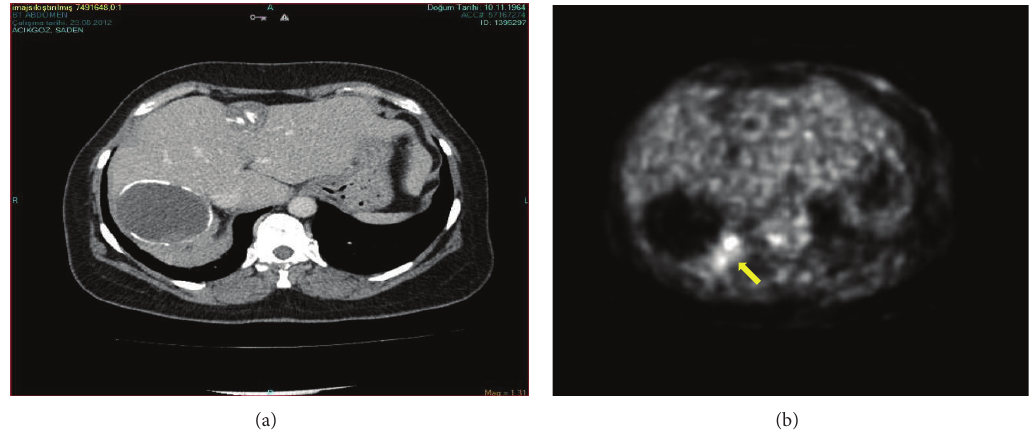
Figure 1: The radiological findings of the patient. (a) Abdominal computed tomography showing a 65×55 mm stage 5 hydatic cyst in the right hepatic lobe and a 30 × 28 mm in the left hepatic lobe, (b) FDG18 positron emission tomography of the patient on which the mass revealed a high activity of FDG. Yellow arrow shows the high suvmax activity area (suvmax